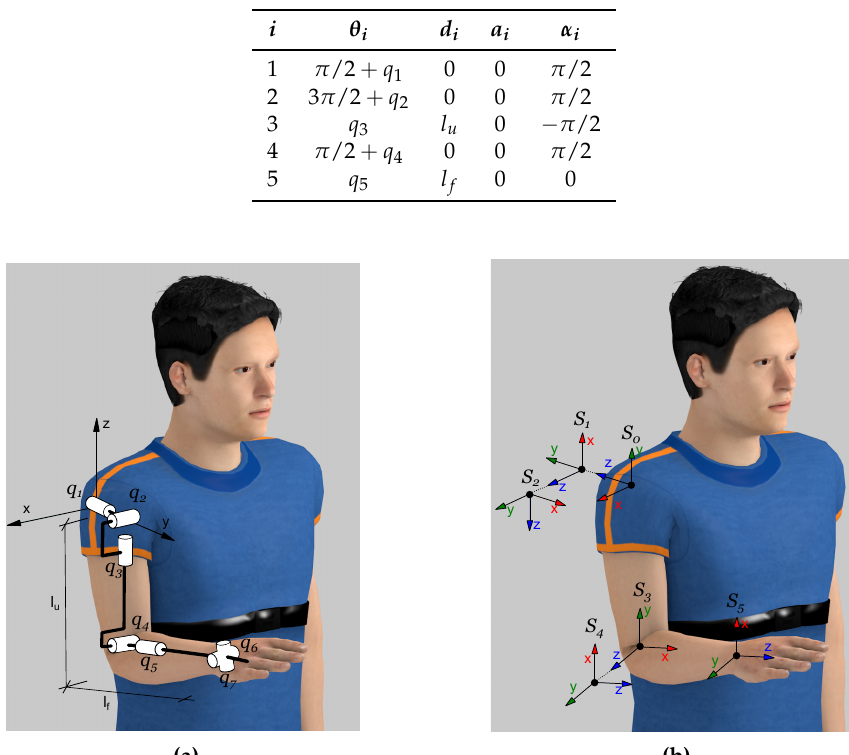
Figure 2. Human arm joints. ( a ) Simplification of human arm joints with seven DoFs; ( b ) Denavit–Hartenberg (DH) coordinate systems of the arm with five